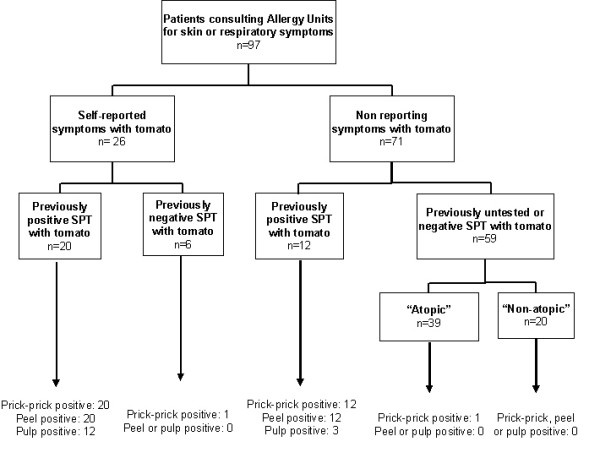
Inclusion algorithm. SPT: Skin prick test.